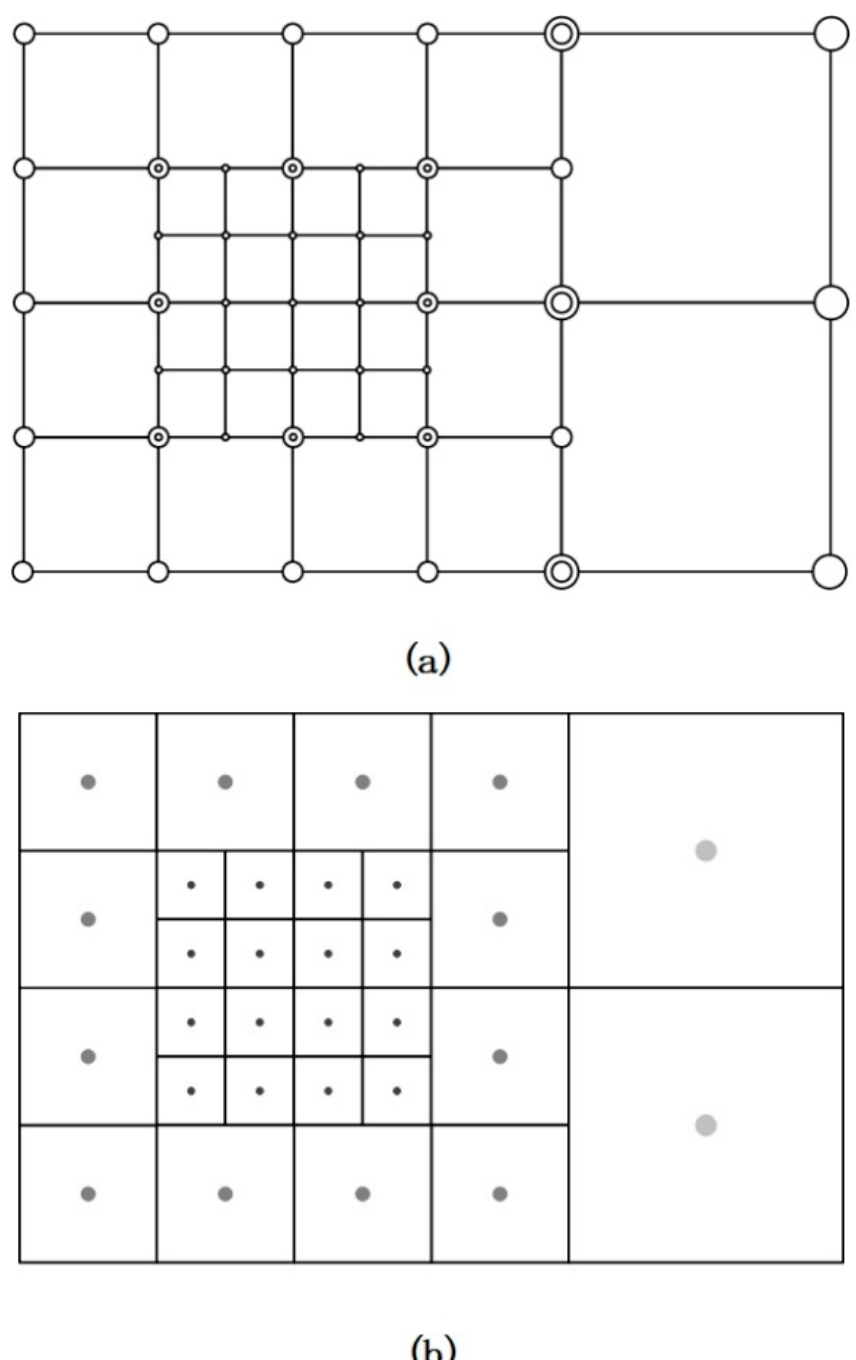
Figure 3. Two grid arrangements at the refinement interface. The circles indicate the grid points where the grid information is recorded, where large circles indicate coarse grid cells and small circles indicate fine grid cells. In the node-based approaches ( a ), the coarse and fine grid cells are overlapped in the intersection part of the grid with different layers. In the volume-based approaches ( b ), all the grid information is recorded by the grid center point.